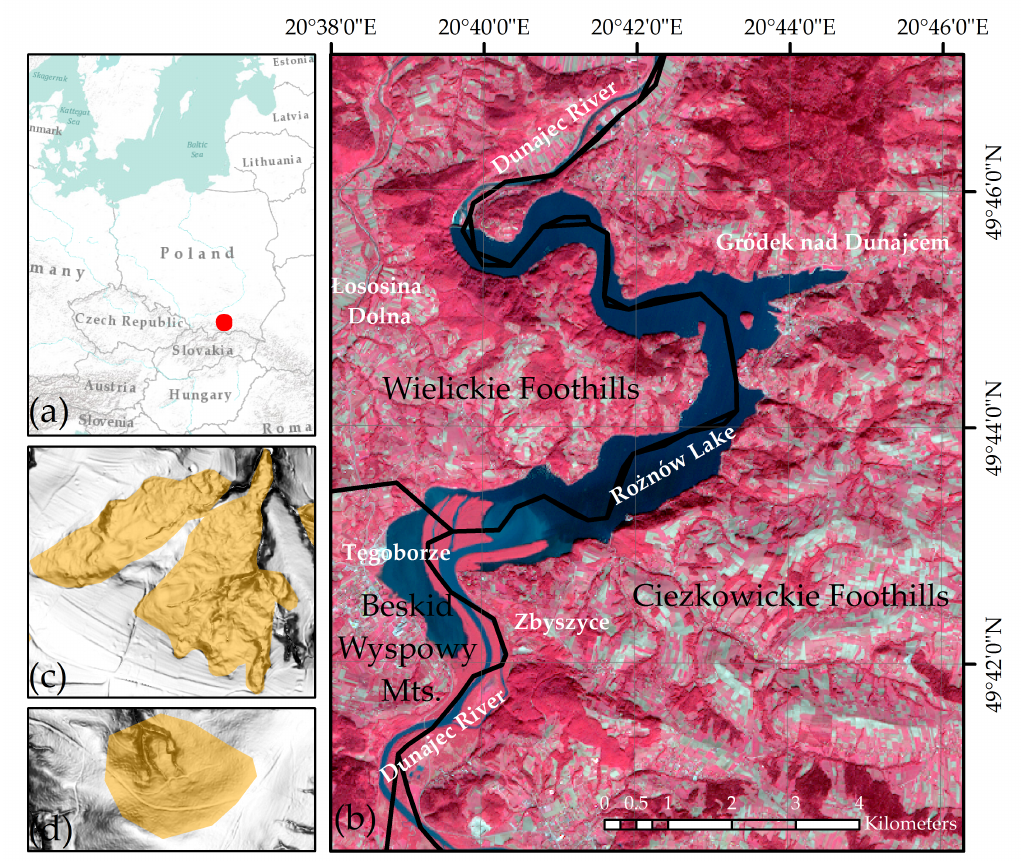
Figure 1. Location of the study area ( a ) with a false color image (spectral bands: 4-3-2) of a Sentinel-2A image ( b ) acquired 3 / 10 / 2015. Examples of landslide shapefile from the national landslide database (SOPO) for ( c ) landslide with visible terrain roughness and ( d ) landslide with smoothed